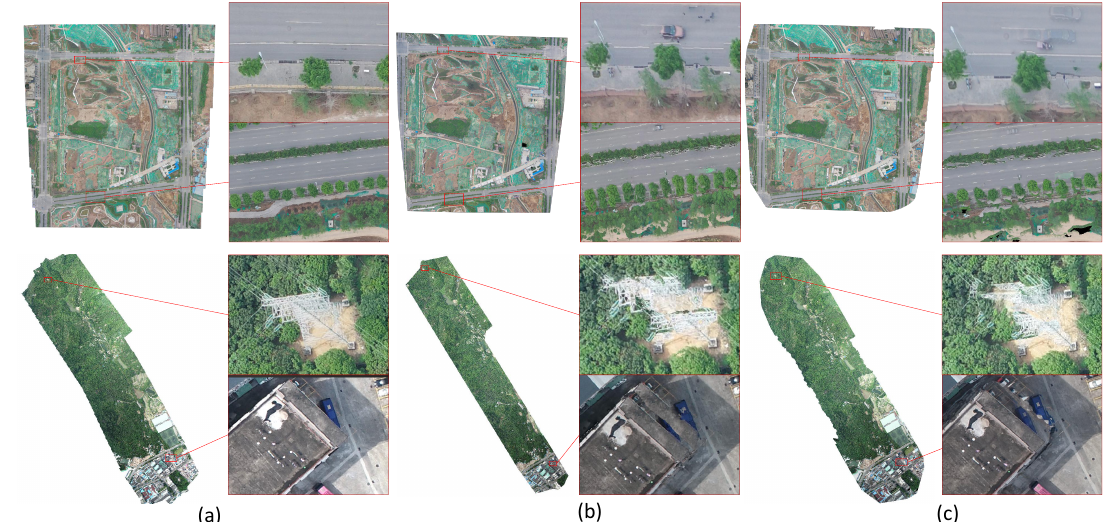
Figure 4. ( a ) Proposed method comparison with ( b ) DJITerra and ( c ) Pix4DMapper on sequence mavic2-roads and mavic-factory . An emphasis (e.g., red arrows) on the important differences between the results is provided to obtain clear comparisons. Homography projection is used; thus, the lines remain straight in our results, and the details show that our live mosaic looks even better than the offline results of state-of-the-art commercial software in some